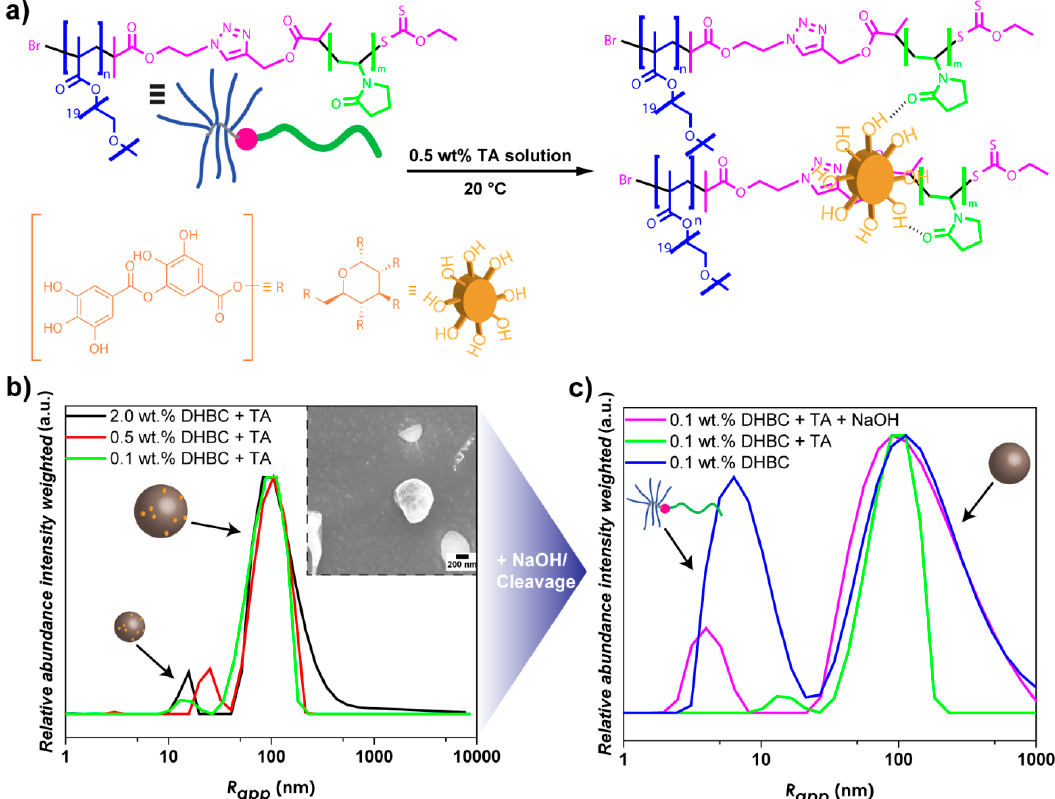
Figure 2. ( a ) Schematic overview of the non-covalent crosslinking reaction of PVP- b -P(OEGMA) with tannic acid (TA). ( b ) Intensity-weighted aggregate size distribution of PVP- b -P(OEGMA) after crosslinking with TA in Millipore water, measured via DLS at 25 °C (Inset: Cryo-SEM image of PVP- b -P(OEGMA) at a concentration of 2.0 wt.% after crosslinking with TA). ( c ) Intensity-weighted size distributions of PVP- b -P(OEGMA) measured via DLS at 25 °C before and after the non-covalent crosslinking procedure via TA, and the subsequent disassembly of aggregates via the addition of NaOH at 2.0 wt.%.